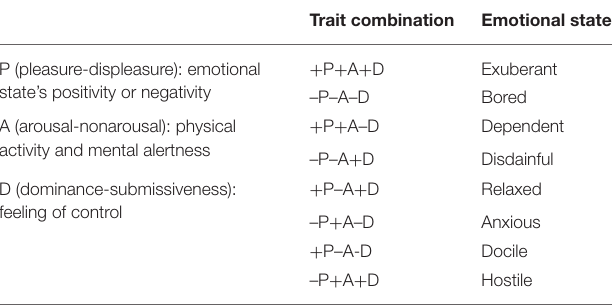
TABLE 1 | Mapping of the eight Mehrabian basic emotions in PAD space. Trait combination Emotional